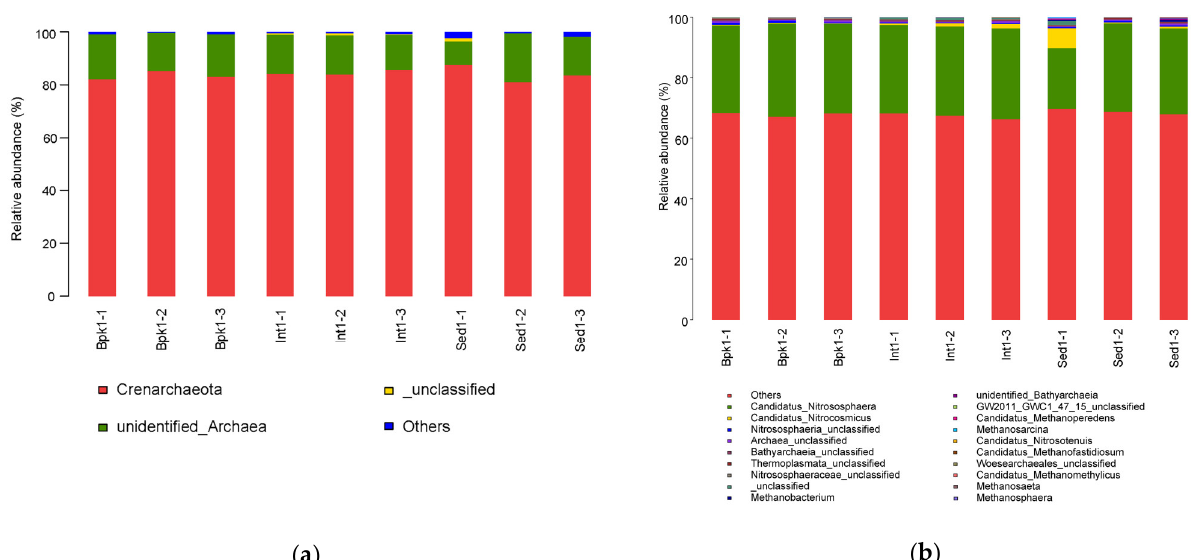
Figure 2. Bar charts of relative species abundance of bacteria at the phylum level ( a ) and genus level ( b ).